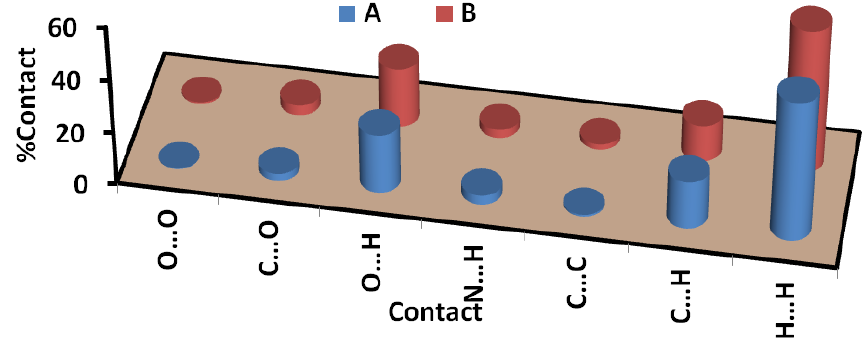
Figure 5. Intermolecular contacts in 4 .